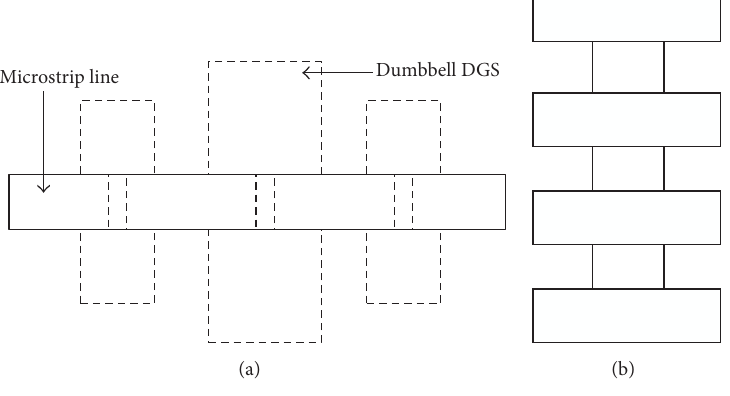
Figure 2: Periodic DGS: (a) HPDGS; (b) VPDGS [29, 34].